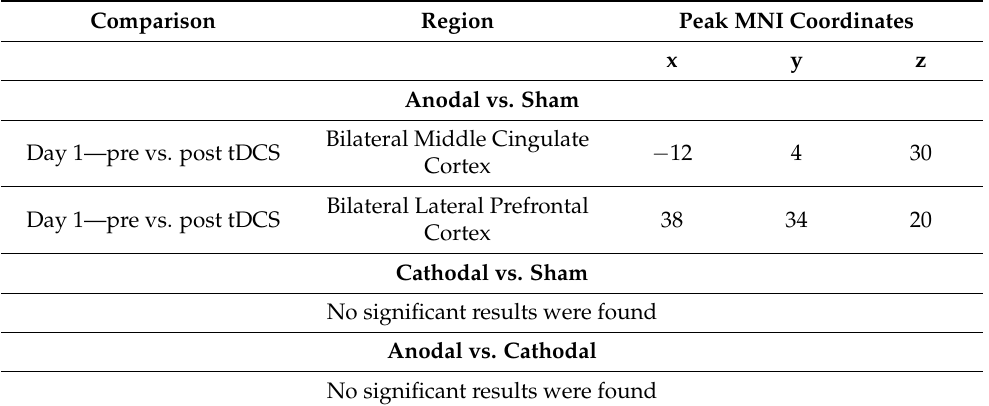
Table 2. ASL statistical analysis between the three group comparisons. The threshold was set at p < 0.05 and Z > 1.64.